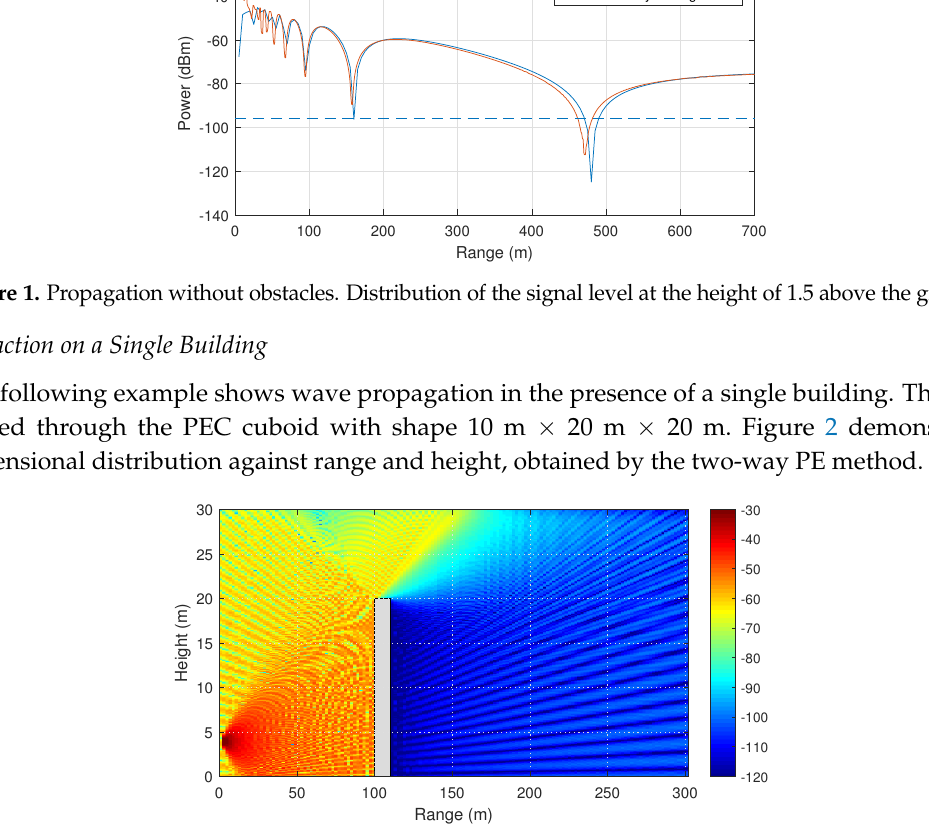
Figure 2. Diffraction on a cuboid. Two-dimensional distribution of the signal level (dBm) calculated by the two-way PE method.